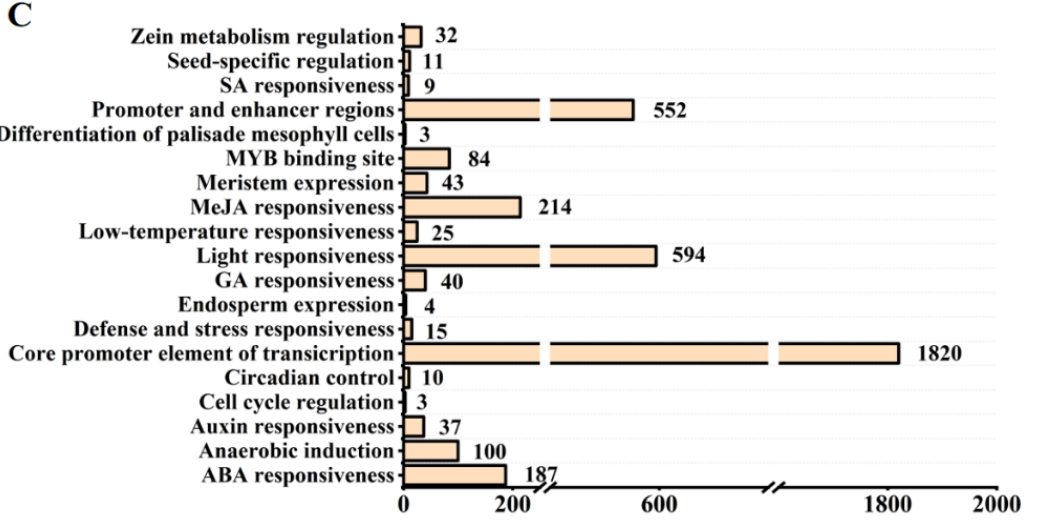
Figure 2. Gene structure and cis-elements of OsPMEI family members in rice. ( A ) Motifs and gene structures of OsPMEIs ; ( B ) Cis-elements in the promoter regions of OsPMEIs ; ( C ) Statistics of cis-elements of OsPMEIs.